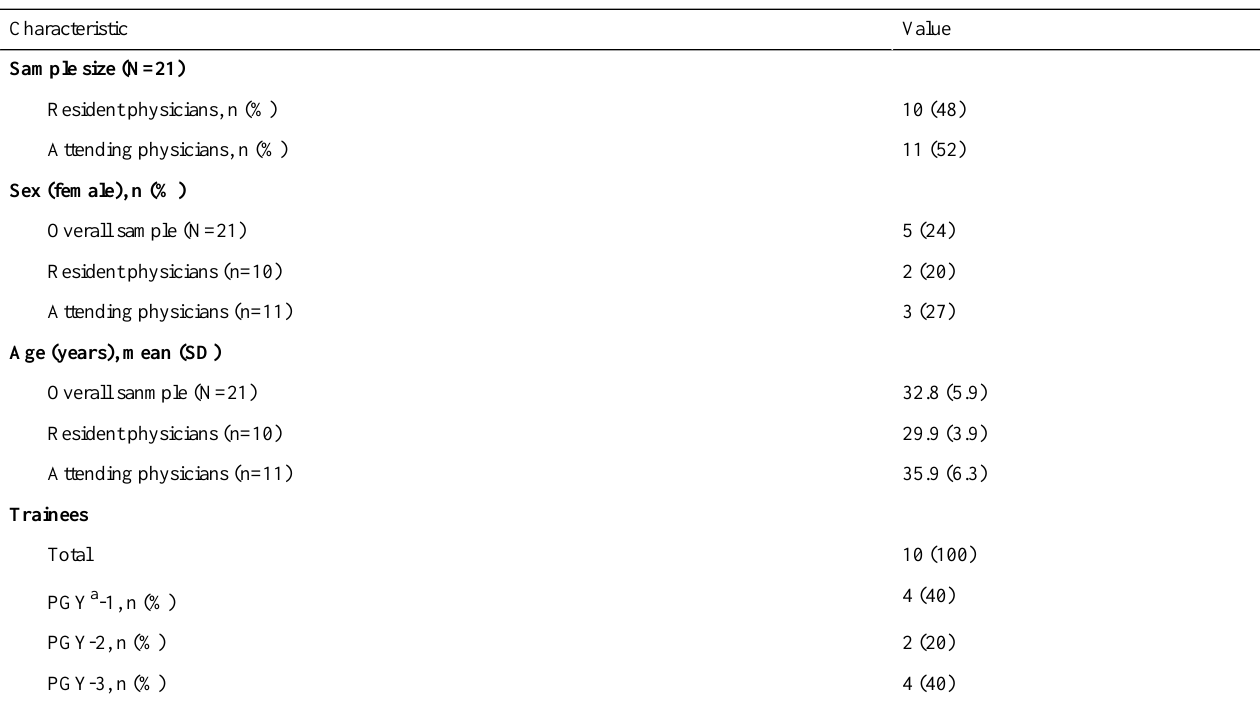
Table 1. Descriptive characteristics of participants included in the